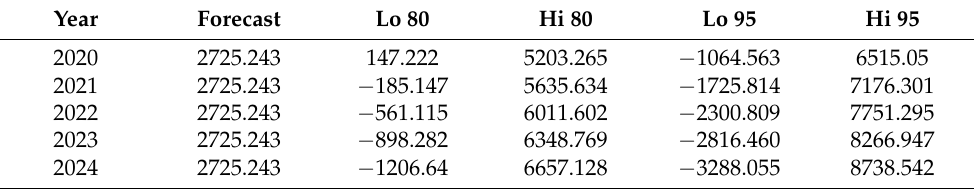
Table 3. Forecast total fish annual biomass landings from 2019 to